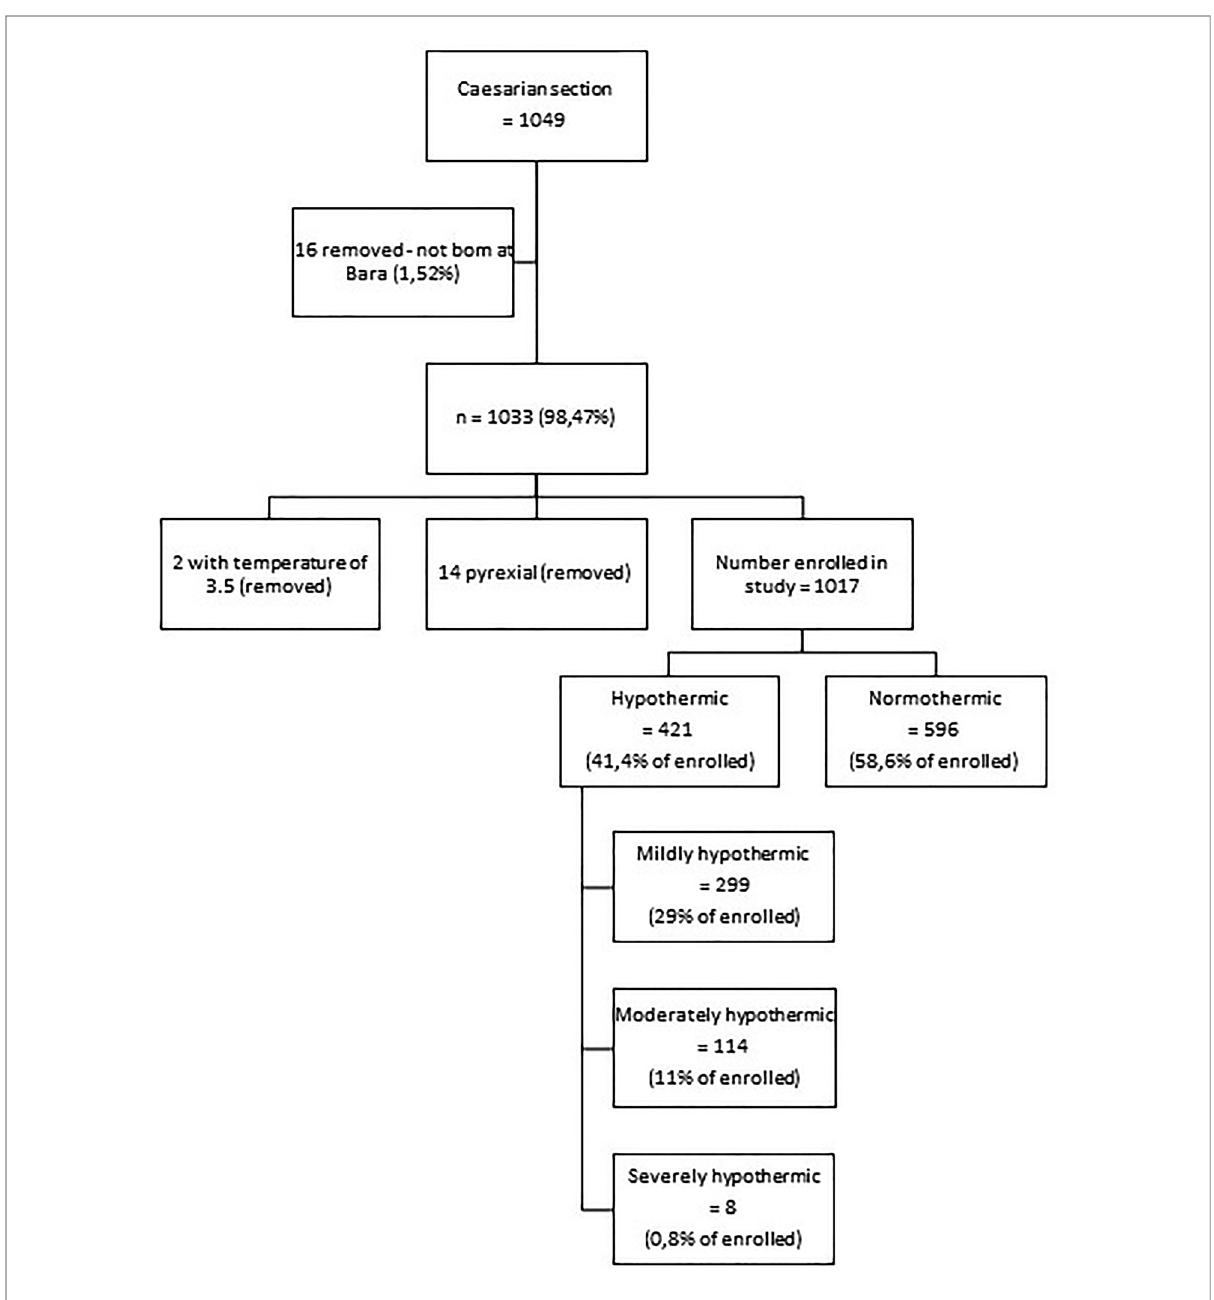
FIGURE 1 Consort